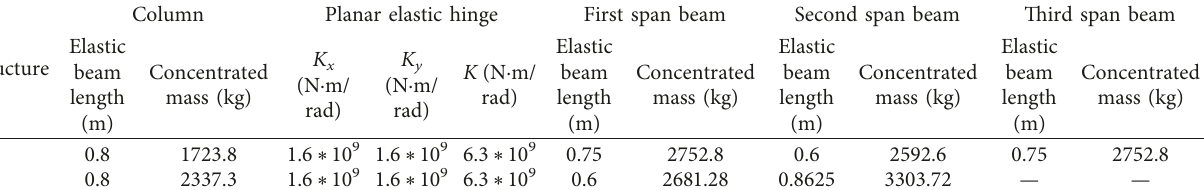
Figure 7: Simplified model diagram. Table 1: Structure parameter.